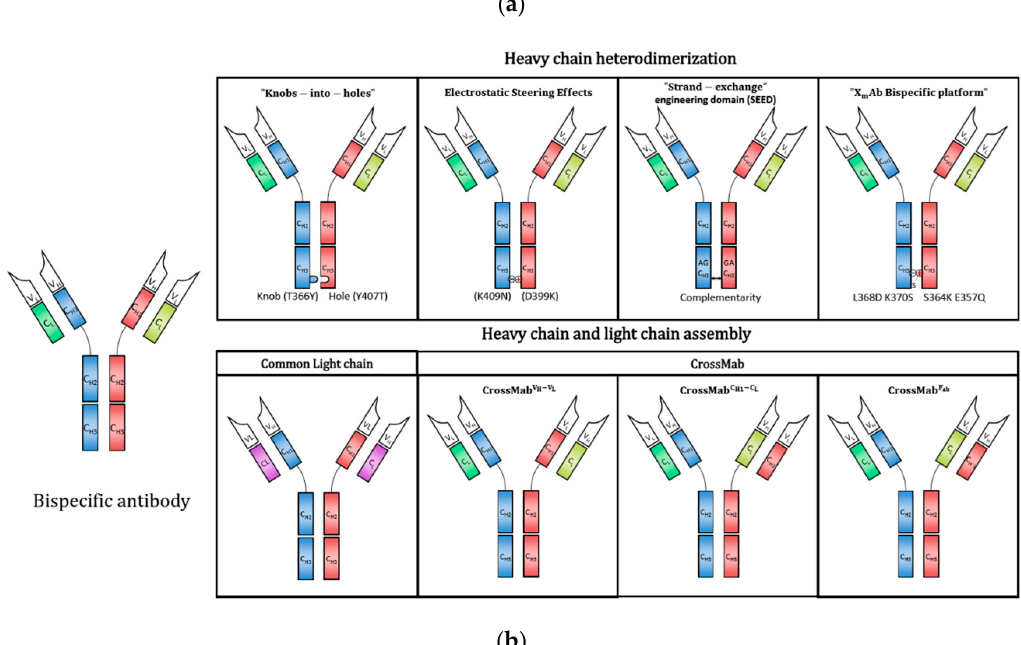
Figure 3. The strategies for improving IgG-like bispecific antibody product quality. ( a ) The illustration of quadroma technology. ( b ) A summary of the heavy and light-chain genetic and protein engineering strategies to achieve homogeneous asymmetric heterodimeric bispecific antibody product.